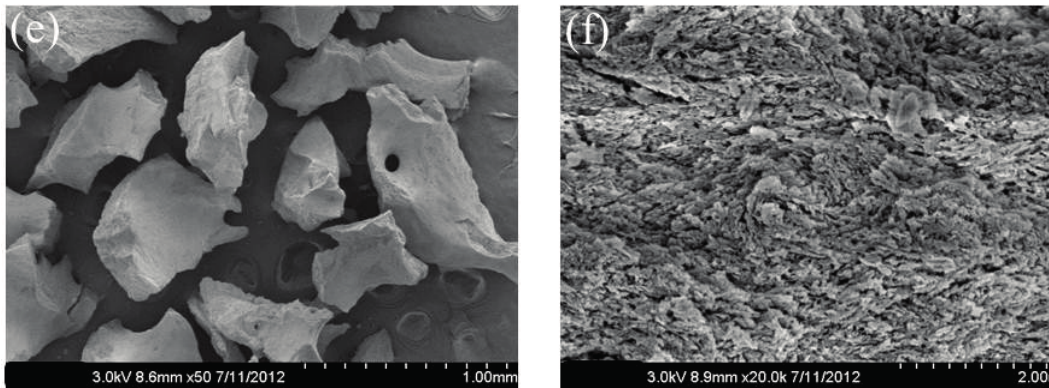
Figure 1. Scanning electron microscopy (SEM) of ( a ) Bio-Oss ® ; ( c ) heparinized Bio-Oss ® ; ( e ) heparinized rhBMP-2-Bio-Oss ® (original magnification ×50); higher magnification images (×20,000) of ( b ) Bio-Oss ® ; ( d ) heparinized Bio-Oss ® ; and ( f ) heparinized rhBMP-2-Bio-Oss ® .